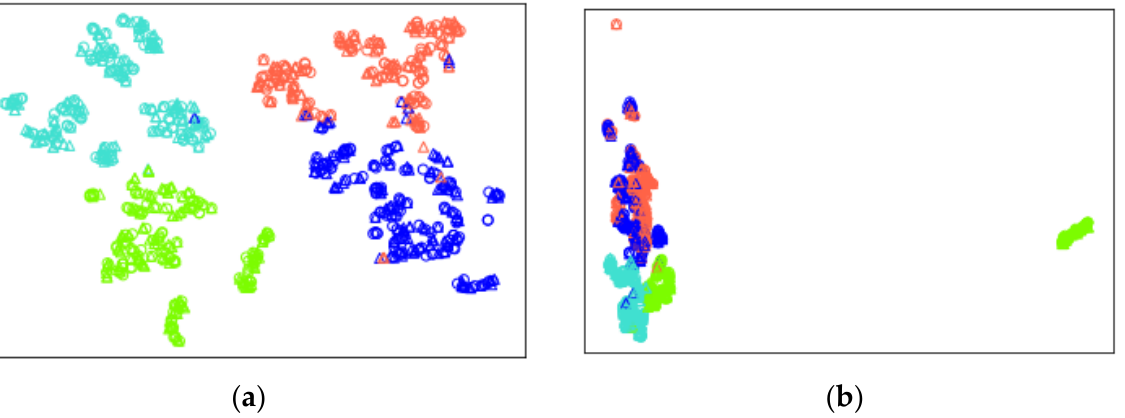
Figure 14. The visualization results of the learned features using different methods for task T4. The different colors represent different athletes’ balance control ability levels: ( a ) the result of our proposed method; ( b ) the result of the DNN method.